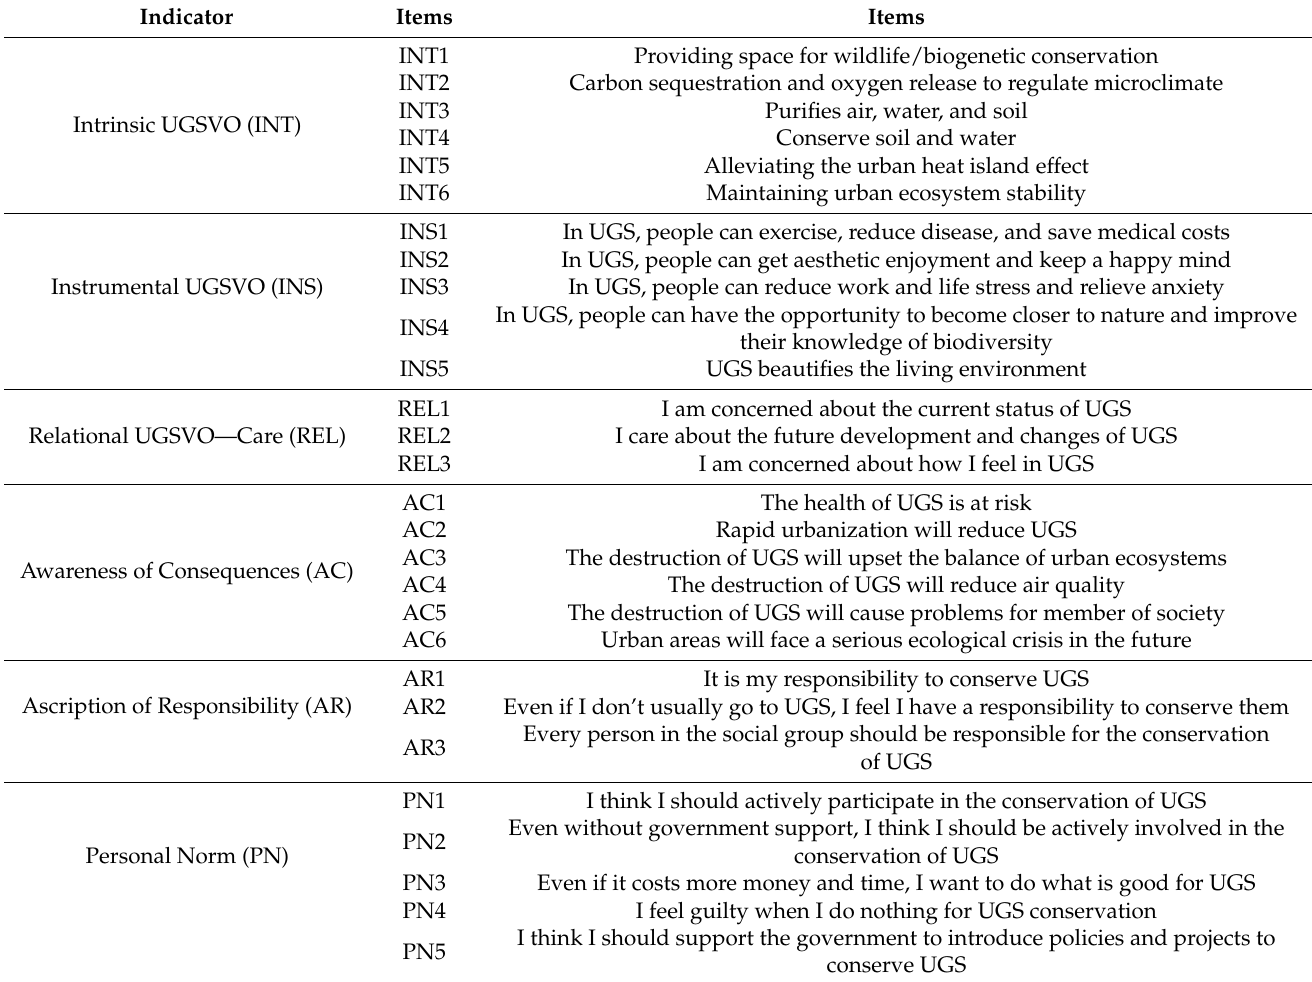
Table 1. Questionnaire items and variables